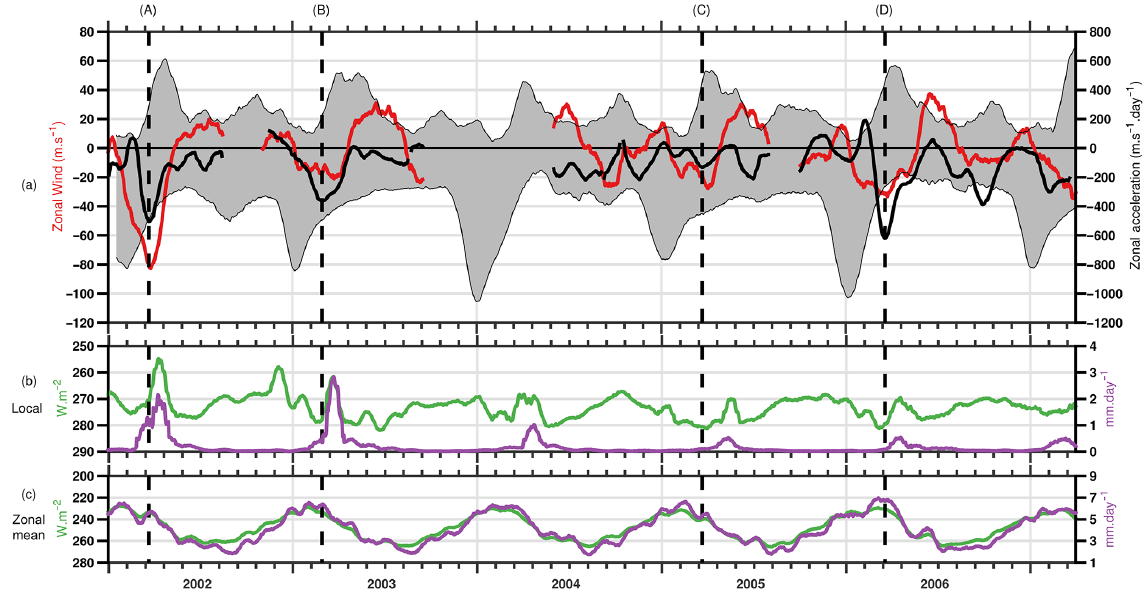
Figure 3. Panel (a) shows monthly-mean zonal acceleration (black) calculated between height gates centred at 85 and 88km and correspond- ing monthly-mean zonal wind (red) for the period 2002–2007. Grey shading marks the ECMWF maximum and minimum monthly-mean zonal winds between 0 and 64km. Panels (b) and (c) show monthly-mean OLR (green) and monthly-mean rainfall (purple) data for the same period averaged in (b) a local 5 ◦ × 5 ◦ latitude–longitude box and (c) a zonal band of 5 ◦ latitude. In both panels (b) and (c) the region is centred on Ascension Island. Dashed lines A–D specify the time of peak westward accelerations during the first phase of the